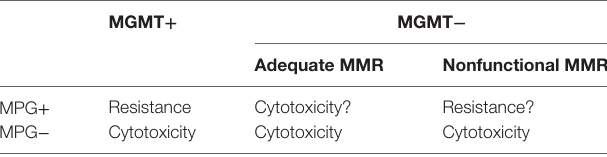
TABLe 1 | Response to temozolomide treatment according to immuno- expression of MGMT, MPG, and functional